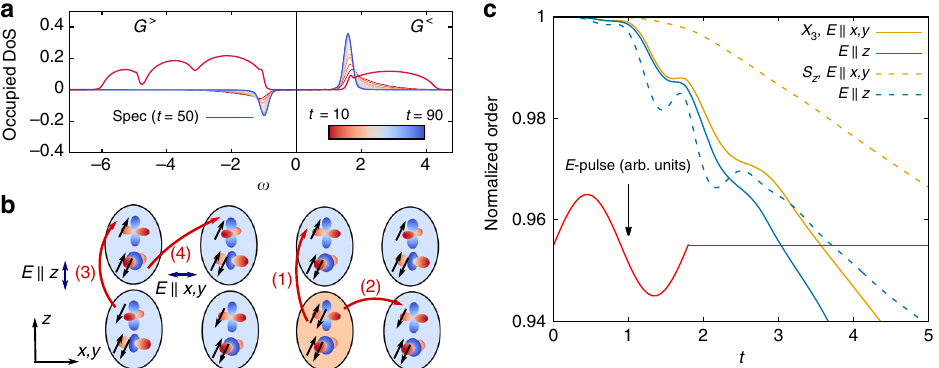
Fig. 4 The electronic processes occuring in the photo-excited state. a Relaxation of charge excitations and the photo-excited state in the long-time limit. G < ð ω ; t Þ at ω > 0 corresponds to the distribution of 4-particle excitations at ω > 0 while G > ð ω ; t Þ at ω < 0 shows the distribution of doublons (see methods). The red solid line is the density of states (spectral function) at t = 50. b The charge excitations created by pulses perpendicular/parallel to the ferromagnetic plane. A parallel pulse ( E k x ; y ) creates spin-triplet excitations in process 4, while a perpendicular pulse ( E k z ) is polarized along the AF- axis and directly creates spin-singlet excitations in process 3. Processes 1 and 2 indicate possible hopping processes of 4-particle excitations. The lattice site of the 4-particle excitation is of orange color. Blue arrows indicate the polarization of the electric fi eld. c The non-equilibrium melting of spin and orbital order under a one-cycle electric fi eld pulse of E 0 = 0.6. The solid (dashed) lines show X 3 ( S z ) normalized by their initial